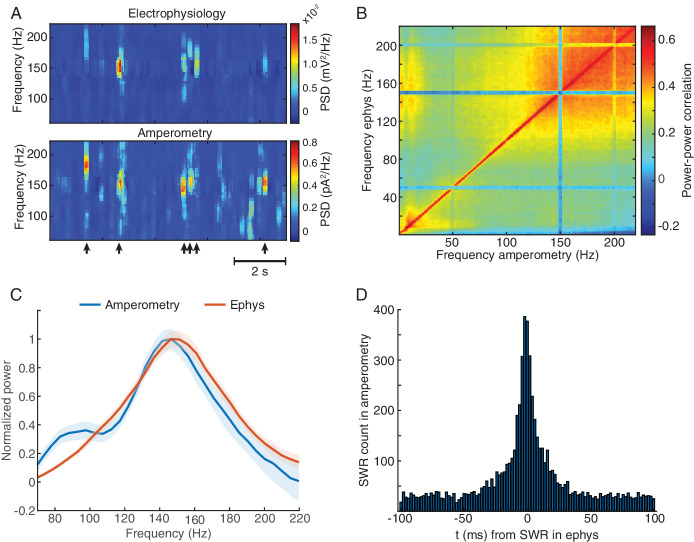
Amperometric currents reliably track LFP spectral content over a wide frequency range.(A) Representative power spectrogram from high-frequency range of electrophysiology and amperometry derived LFP signals in the CA1 pyramidal layer during NREM sleep. Arrows indicate timings of SWRs detected from LFP. High-frequency bursts captured with both modalities typically coincided in time and exhibited similar spectral features. (B) Comodugram showing high correlation between LFP power, recorded during NREM sleep, from a silicon probe’s site in CA1 pyramidal layer and the power of the amperometric signal from a biosensor site, targeted to the same hippocampal layer. (C) Normalized power spectra triggered to SWRs highlighting the similarity of profiles gathered using both modalities. (D) Cross-correlogram of SWR timings detected using amperometry and electrophysiology, emphasizing the high co-occurrence of these events (n = 8074 for electrophysiology and n = 8085 for amperometry).